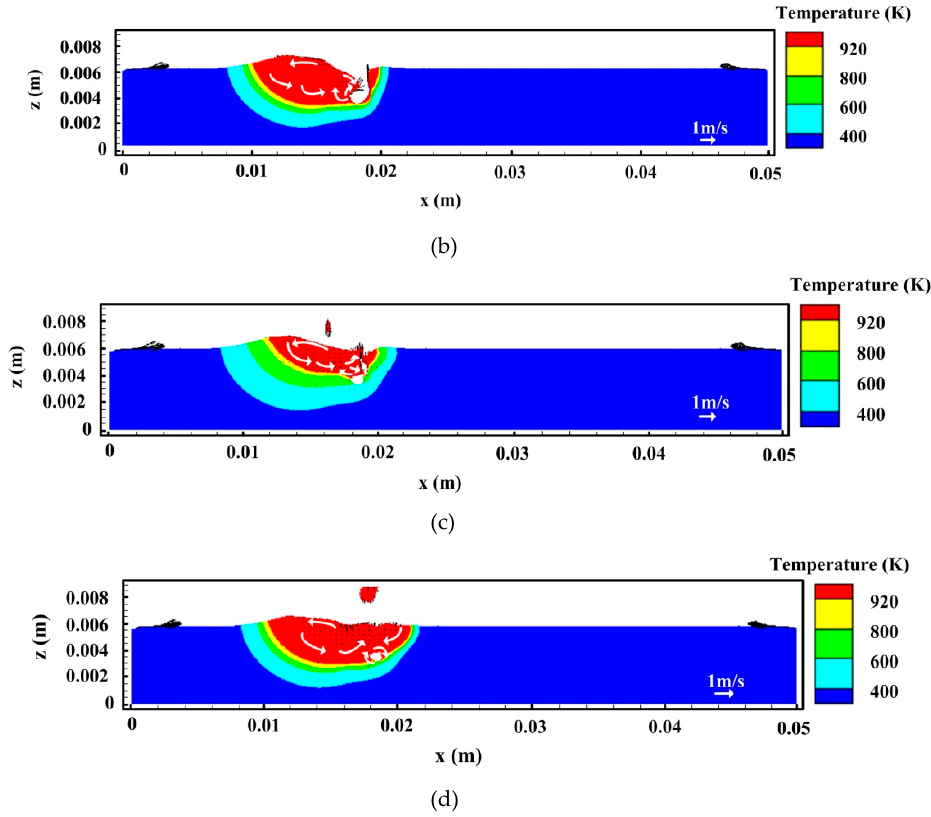
Figure 9. Evolution of the temperature field and fluid flow at the longitudinal section for I = 160 A: ( a ) t = 0.7 s, ( b ) t = 0.71 s, ( c ) t = 0.72 s, and ( d ) t = 0.82 s.